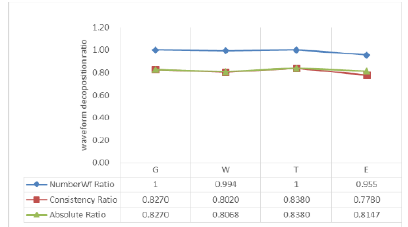
Fig.4 Decomposition comparartion of different filiters with GLAS05